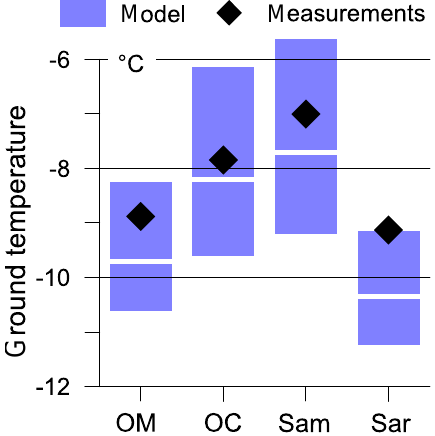
Figure 10. Modeled and measured annual average ground temper- atures for the LRD boreholes for the 2-year period from Septem- ber 2010 to August 2012 (OM: Olenyokskaya Channel mouth; OC: Olenyokskaya Channel center; Sam: Samoylov Island borehole; Sar: Sardakh Island). Blue bar: spread between model runs with snow densities of 200 and 250kgm − 3 ; white line: model run with snow density 225kgm − 3 . The ground temperatures correspond to the depths given in Figs. 7 and 8; for Samoylov, the simulations for the borehole stratigraphy (Sect. 4.2.1, Fig. 8b) are